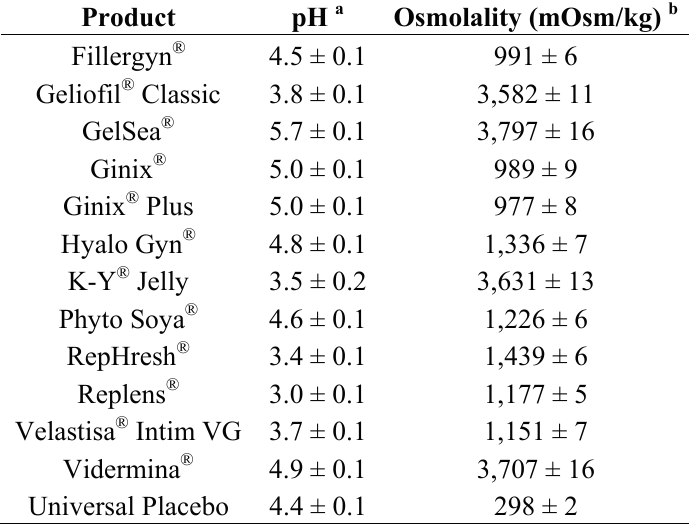
Table 1. pH and osmolality values of tested products. Results are presented as the mean ± SD ( n =